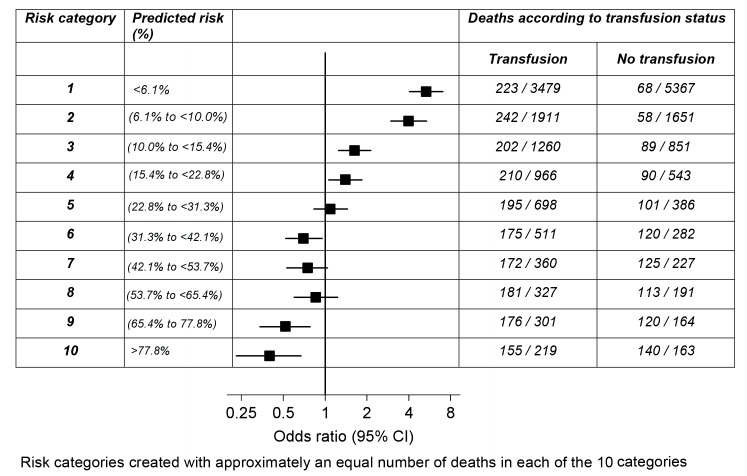
Odds ratio of death for transfusion compared to no transfusion by risk category.